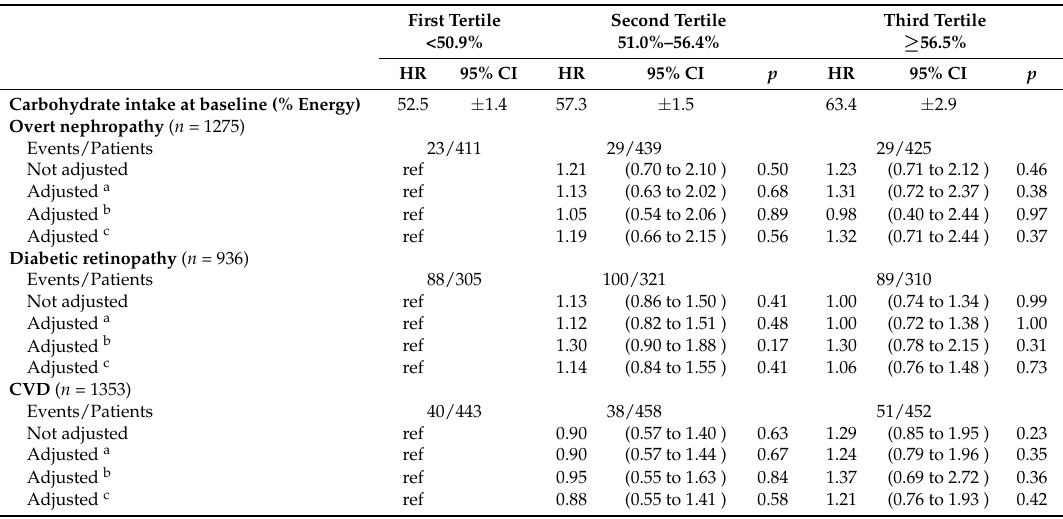
Table 3. Cox regression of diabetes complications after 8 years follow up according to proportion of carbohydrate intake at